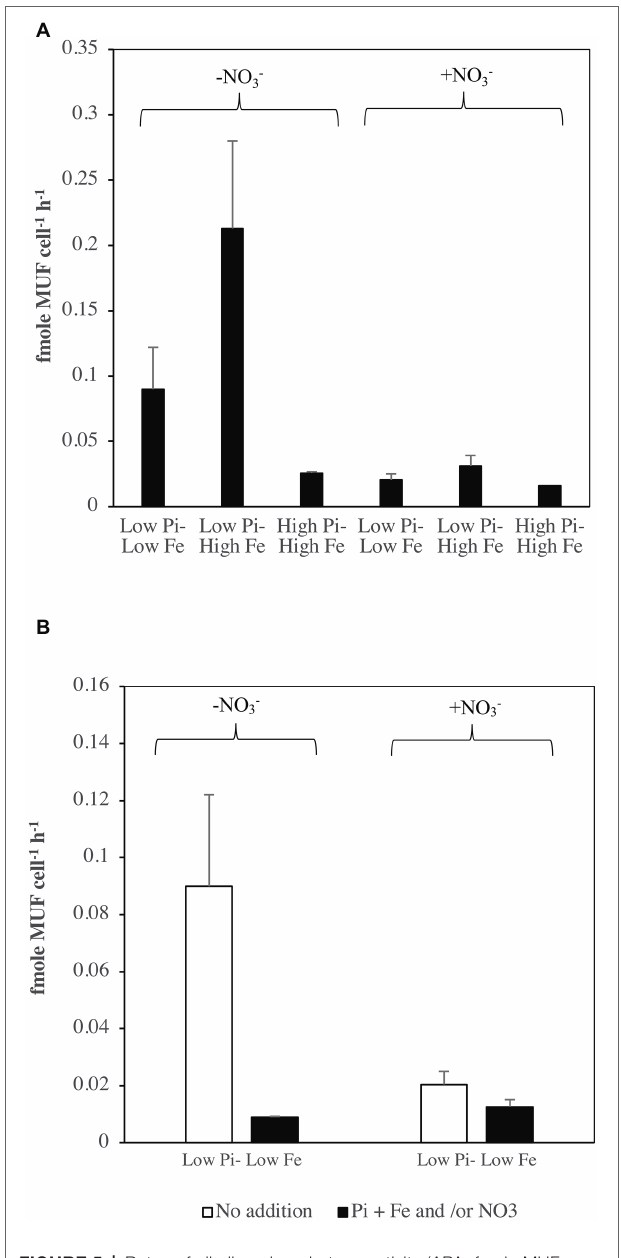
FIGURE 4 | Rates of alkaline phosphatase activity (APA) in Halothece sp. PCC 7418 under optimal 3 NO - and [Low 3 NO - ] conditions. (A) End point assay of APA under optimal and [Low 3 NO - ] conditions with 2 μM of MUF-P. (B) Saturation curve, velocity (V, fmole MUF cell −1 h −1 ) vs. substrate (S, μM) under [Low 3 NO - ] in [Low 3 4 PO - –Low Fe], [Low 3 4 PO - –High Fe], [Medium 3 4 PO - –Medium Fe], and [Medium 3 4 PO - –High Fe], up to 5 μM of MUF-P. 3 4 PO - is represented as Pi. In (A,B) , values are the mean and the error bar is the spanning range between the duplicate measurements. Asterisks (*) indicate significant differences ( p < 0.05) between 3 NO - optimal and [Low 3 NO - ] conditions of the same 3 4 PO - and Fe combination treatments, by individual t student test. Different letters indicate pairwise significant differences ( p < 0.05) among treatments in [Low 3 NO - ] using a post-hoc test (Bonferroni) after ANOVA over the whole dataset was done.